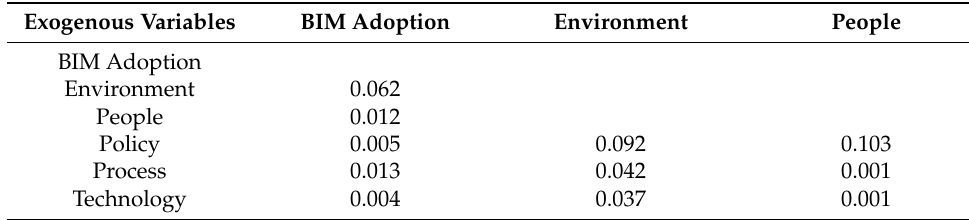
Table 9. F-square Result.